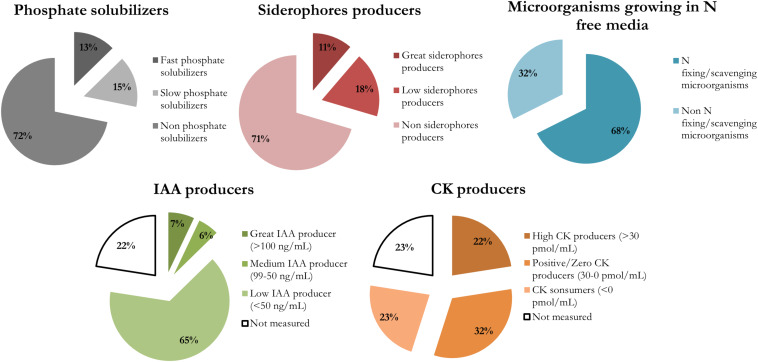
Prevalence of each plant growth promotion trait in the endophytes isolated from cucumber plants pre-treated with a sedimentary humic acid. The traits evaluated were: inorganic phosphate solubilization at 14 days, siderophore production at 7 days, capability of growing in a N-free medium, and phytohormones production (IAA and CKs).